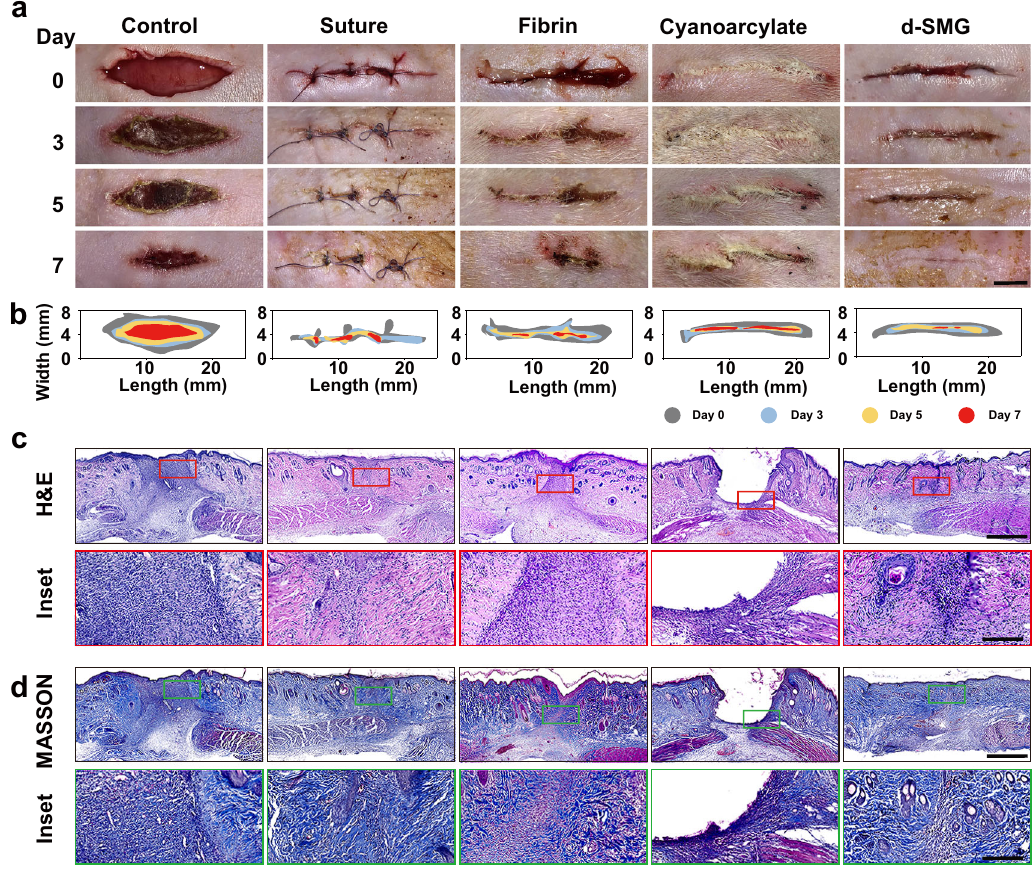
Fig. 5| In vivo wound adhesionef fi cacy of A. fulica d-SMG. a Photographs ofthe rat incised skin after treatments. b Schematic of the dynamic wound healing pro- cessonday0,3,5,and7. c , d H&Estaining( c )andMassonstaining( d )ofthewound